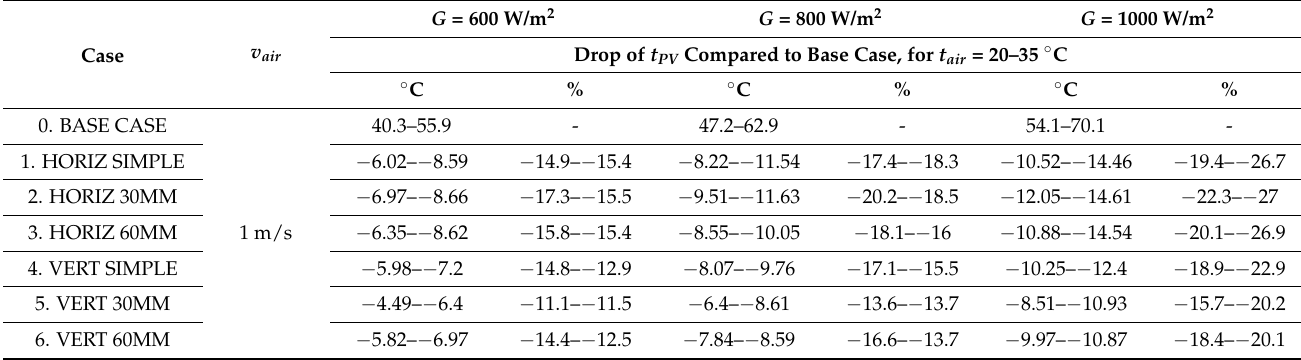
Table 6. Drop of the PV panel operating temperature for ambient air temperatures, t air = 20–35 ◦ C, wind velocity, v air = 1–5 m/s and solar radiation, G = 600–1000 W/m 2